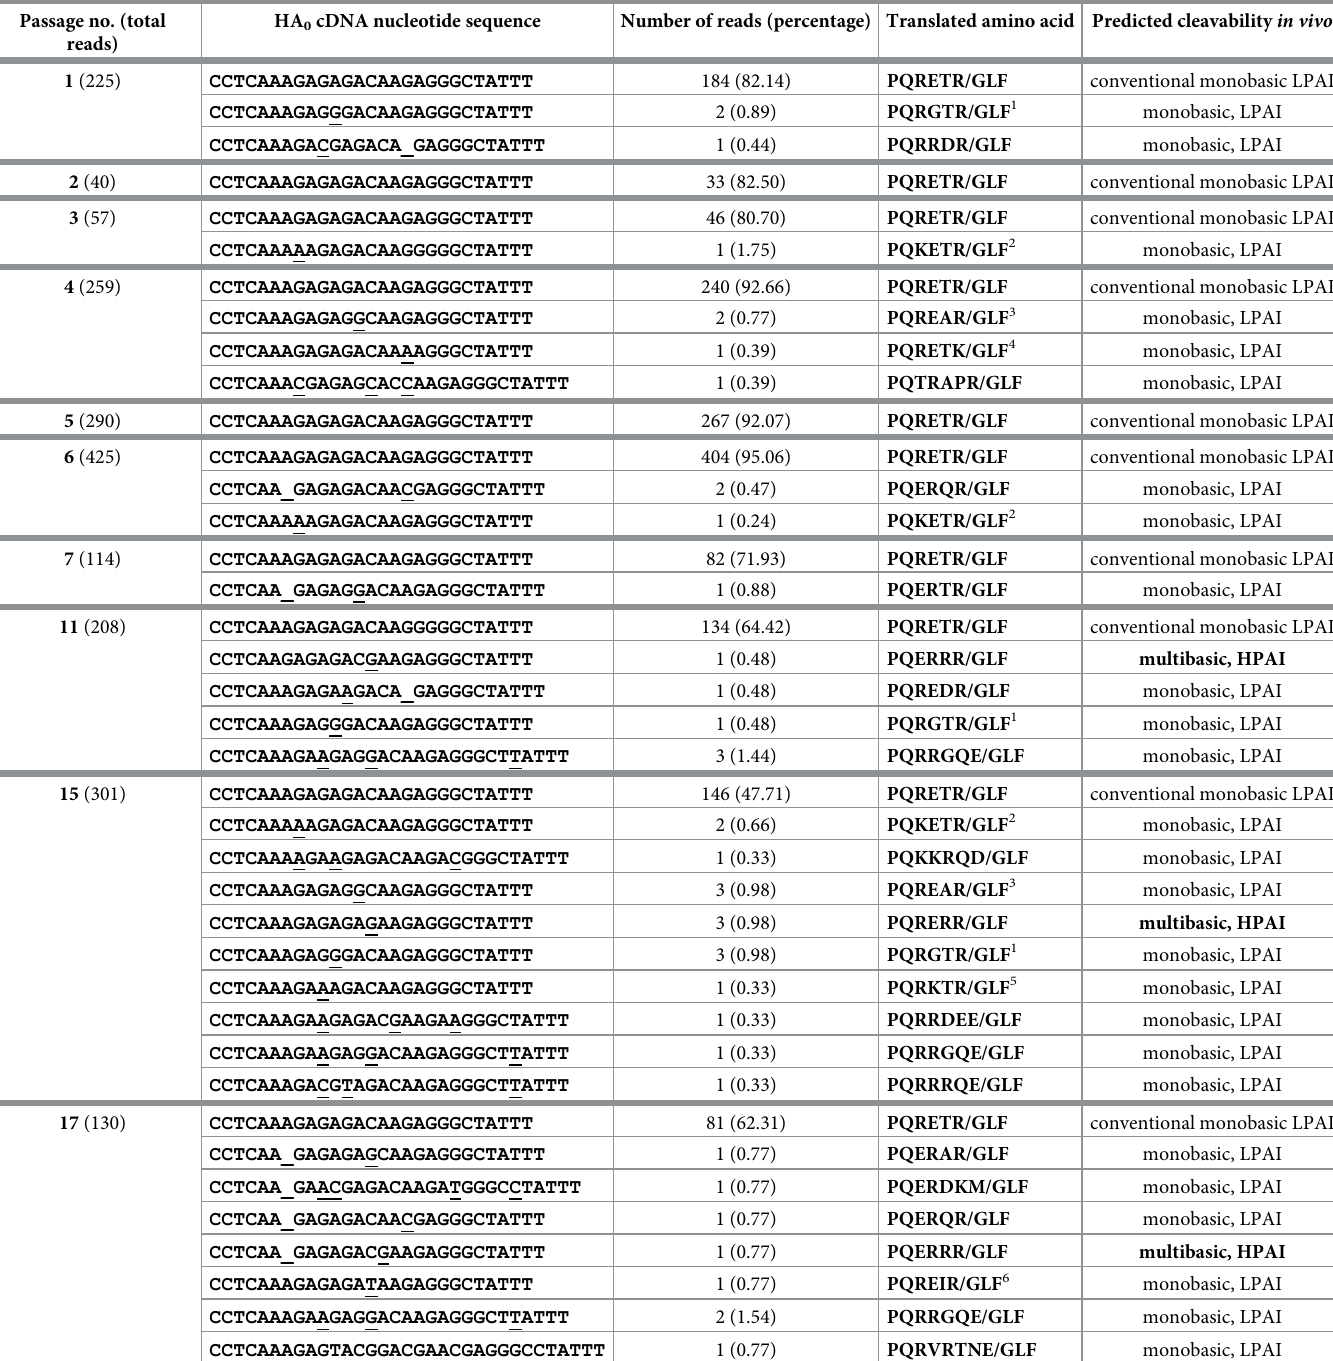
Table 4. Hemagglutinin cleavage sites (HA 0 ) detected in the H5N2 low pathogenic avian influenza virus passaged in 14-day old ECEs. Passage no. (total